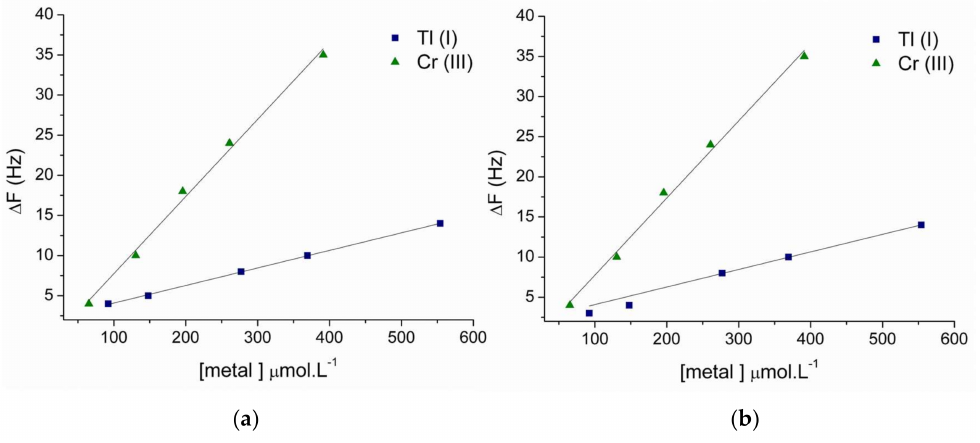
Figure 8. Response of the sensor to Tl + (blue) and Cr 3+ (green) based on: ( a ) NCTPP-MF and ( b ) NCTPP-MF-Py +